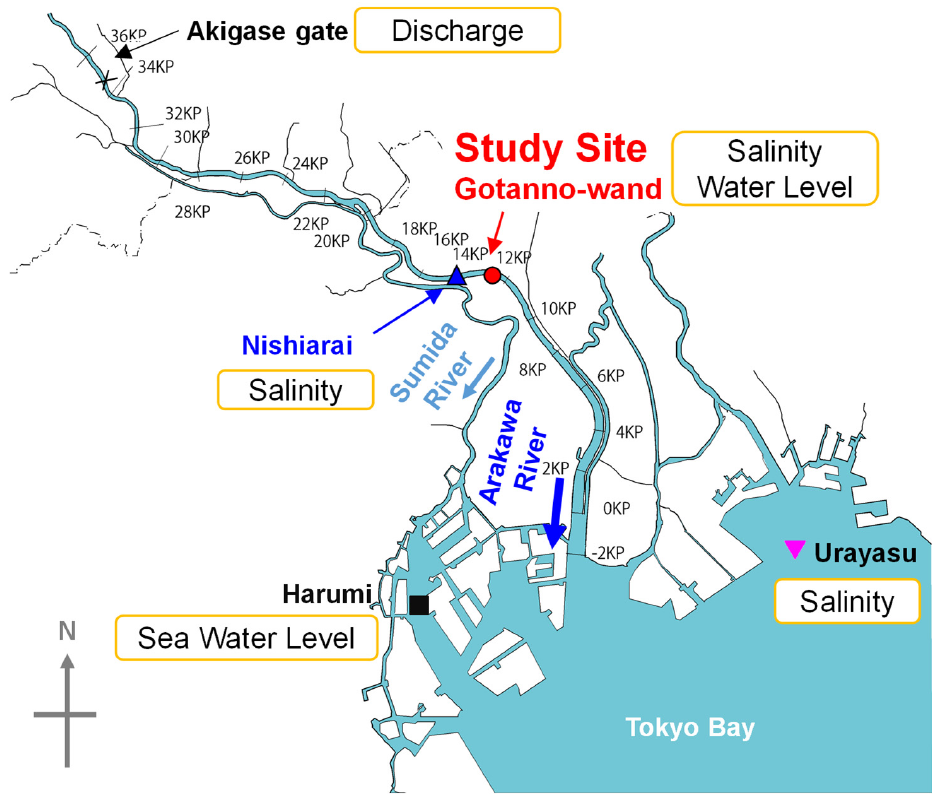
Figure 1. Study site location.